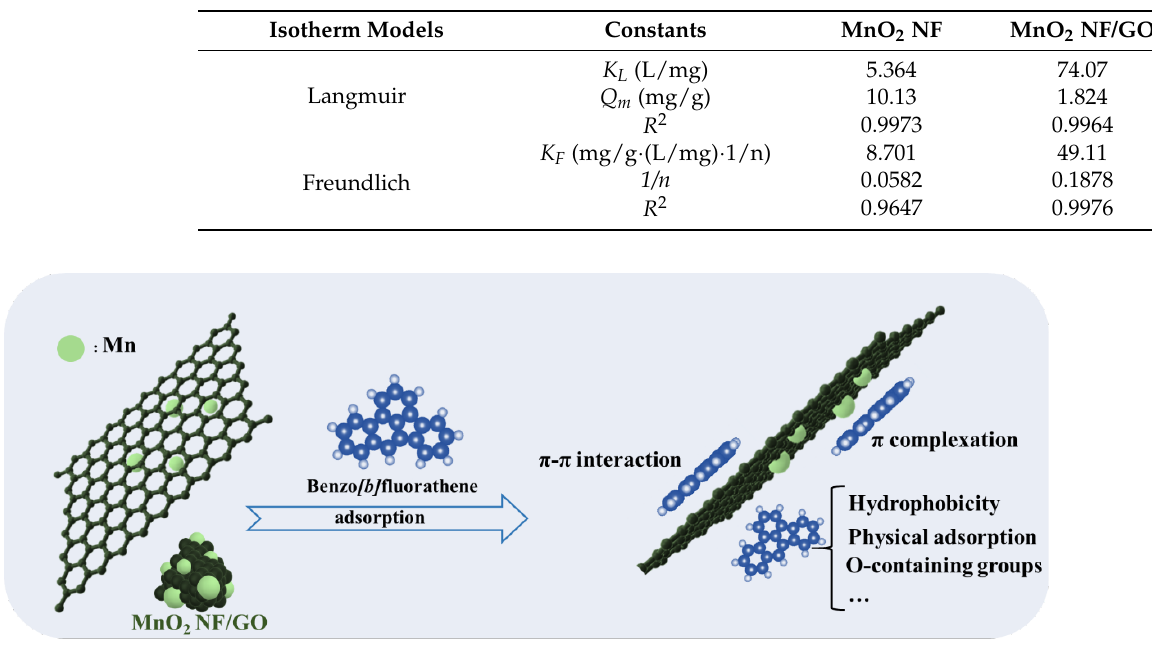
Figure 5. BbFA adsorption mechanism on MnO 2 NF/GO composites.